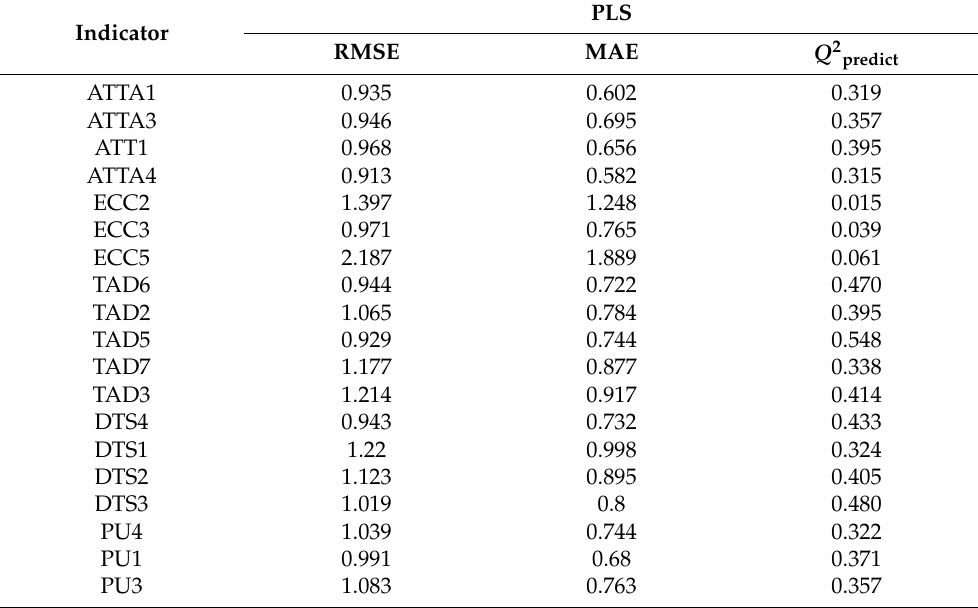
Table 16. Table 16. Q 2 predict values.